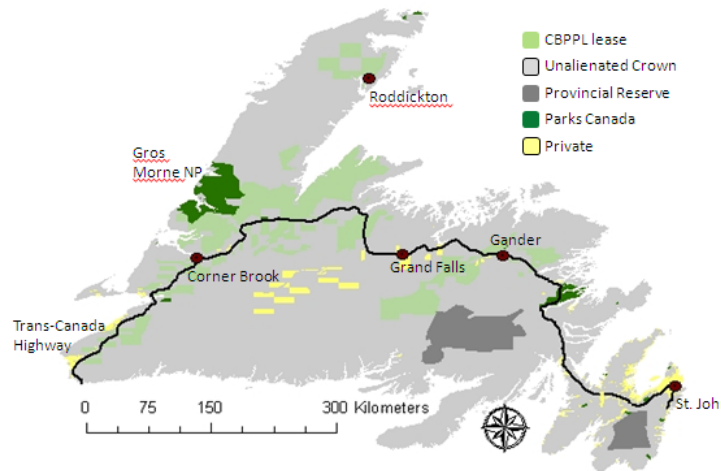
Figure 1 Map of the island of Newfoundland, with tenure system (leased, Crown and other ownerships)